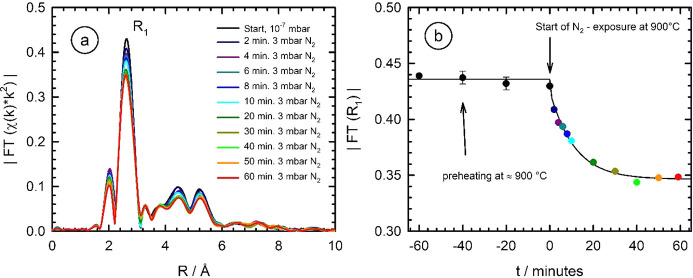
(a) In situ detected structural changes during the N2 exposure (3 mbar) of a stack of Nb foils (2 × 6 µm thickness) at 900°C as a function of time. A clear reduction of all peaks in the magnitude of the Fourier-transformed k
2-weighted EXAFS data FT|χ(k)k
2| are detectable (k-range for the FT: 2.2 Å−1 < k < 10.8 Å−1, the data are not corrected for phase shifts). The intensity of the peak related to the nearest neighbour |FT(R
1)| is plotted as a function of the process time in (b). After 60 min preheating under vacuum at 900°C, the sample was exposed to an atmosphere of dried N2 gas at 3 mbar. Black circles correspond to the pre-heating phase under high-vacuum conditions, while the coloured data points in (b) belong to the treatment in 3 mbar N2 according to the legend in (a). For t > 0, the fit line corresponds to an exponential decay with time.